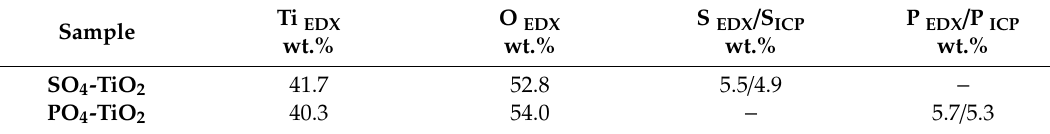
Figure 3. XRD patterns of TiO 2 , PO 4 -TiO 2, and SO 4 -TiO 2 . Table 1. ICP and EDX data of phosphated / sulfated titanium